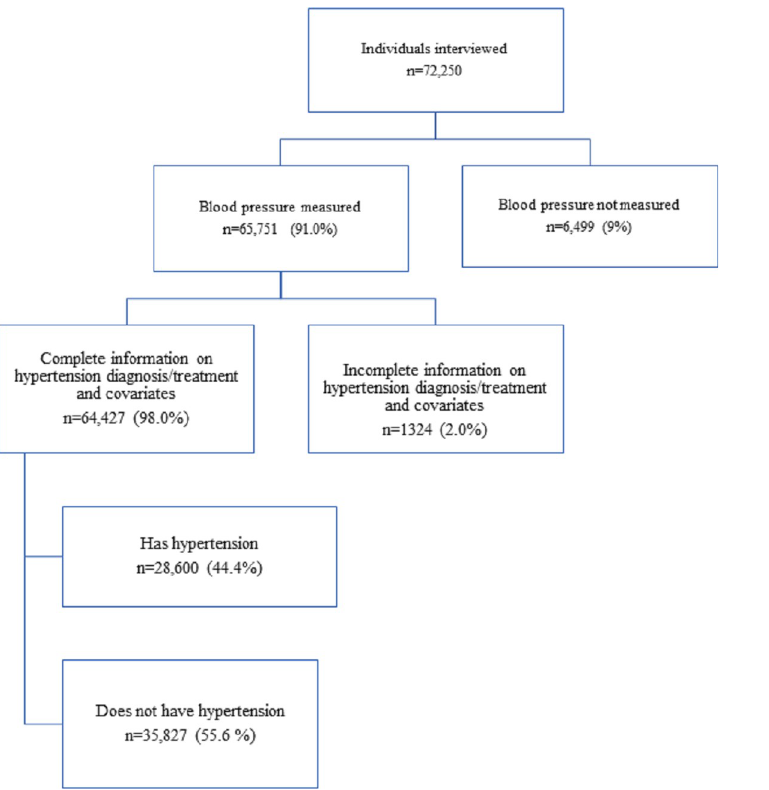
Fig 1. Flowchart of participant selection. Percentage are